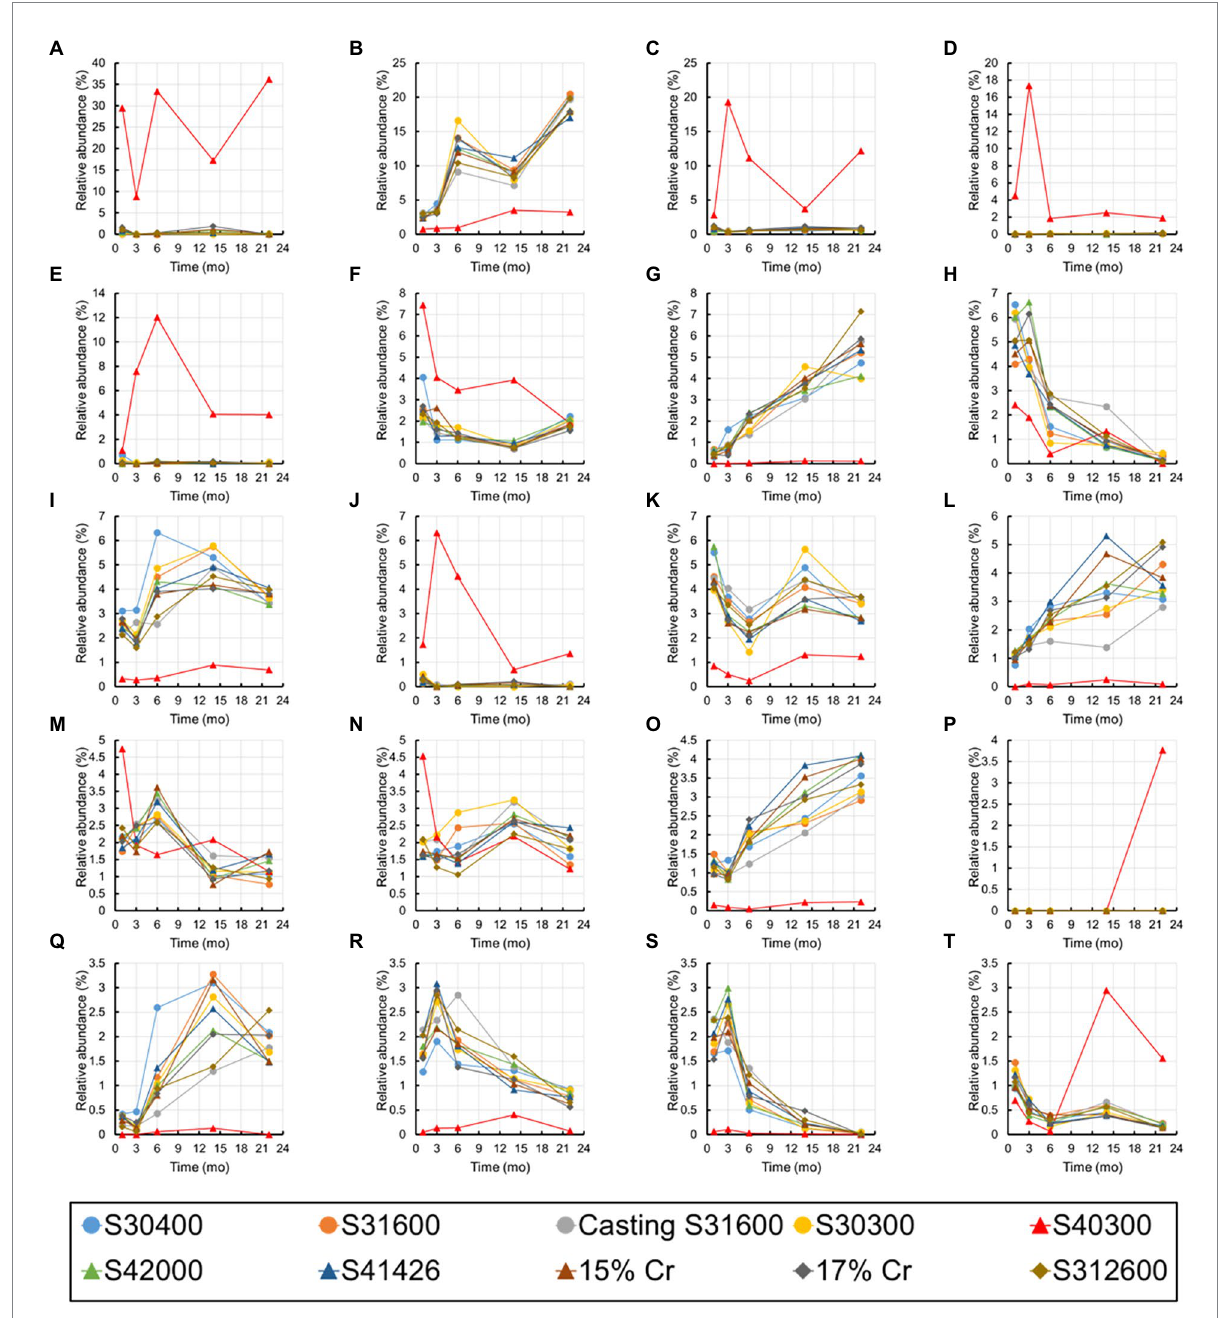
FIGURE 10 Temporal changes in the 20 most abundant OTUs. (A) Family Beggiatoaceae ; (B) Nitrospira ; (C) class Gammaproteobacteria ; (D) Candidatus Tenderia; (E) family Sideroxydans ; (F) family Comamonadaceae ; (G) phylum Myxococcota ; (H) class Cyanobacteriia ; (I) family Vicinamibacteraceae ; (J) Ferritrophicum ; (K) family Gemmataceae ; (L) order Vicinamibacterales ; (M) family Microscillaceae ; (N) phylum Planctomycetota ; (O) order Burkholderiales ; (P) Leptospirillum ; (Q) Luteitalea ; (R) family Nitrosomonadaceae ; (S) family Anaerolineaceae ; and (T) order Rhizobiales